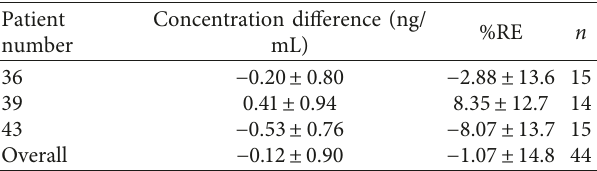
Table 3: Deviation between the hydromorphone plasma con- centrations when re-analyzed in 2019 from thawed samples after more than three years and the first measurements in